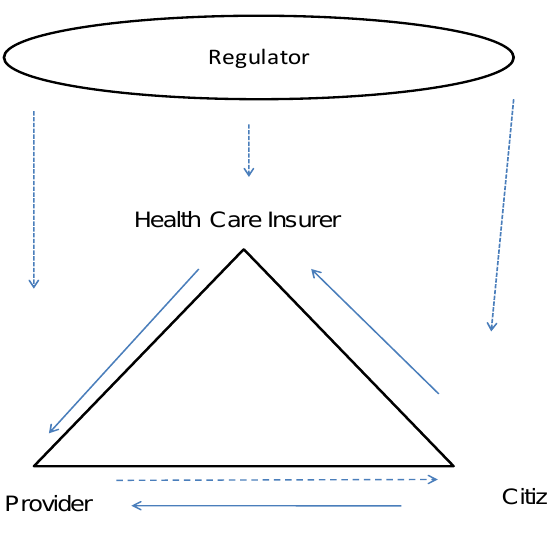
Figure 1: The health care